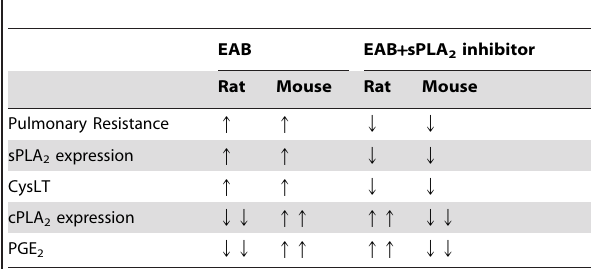
Table 2. Physiological and biochemical markers of OVA- induced EAB in rat 1 and mouse 2